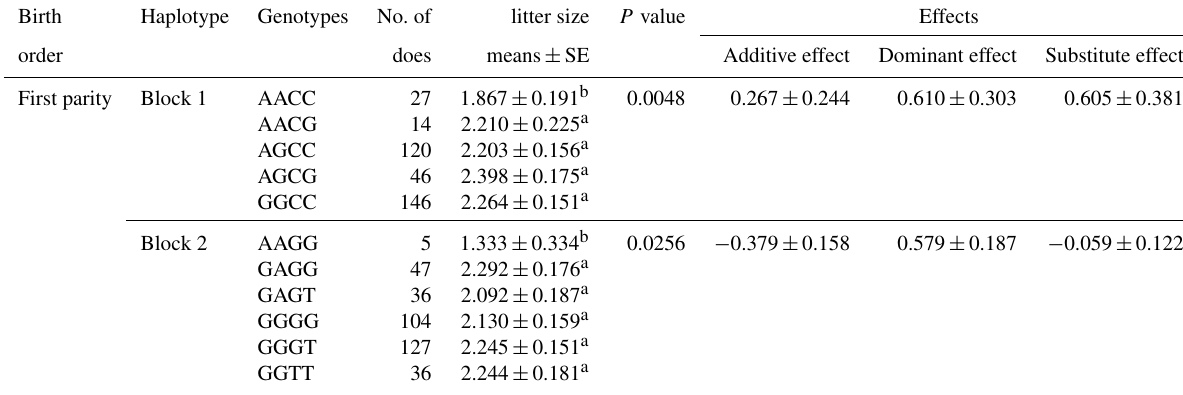
Table 5. Significantly associations between the multiple markers and litter size in Nubian goat. Birth Haplotype Genotypes No. of litter size P value Effects order does means ± SE Additive effect Dominant effect Substitute effect First parity Block